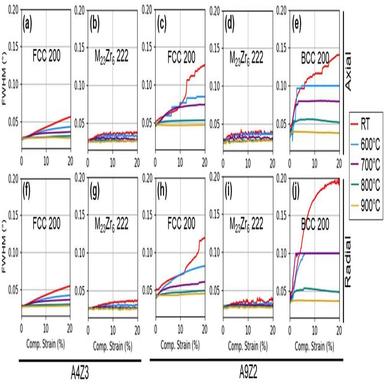
Model results for the FWHM evolution of FCC 200, M23Zr6 222 and BCC 200 peaks during compression at RT, 600 °C, 700 °C, 800 °C, and 900 °C of A4Z3 axial (a, b), A9Z2 axial (c–e), A4Z3 radial (f–g) and A9Z2 radial (h–j). The results indicate signs of misfit and loss of track of the model for the axial and radial curves for A9Z2 BCC 200 at 600 °C and 700 °C. For colors, please see digital version.